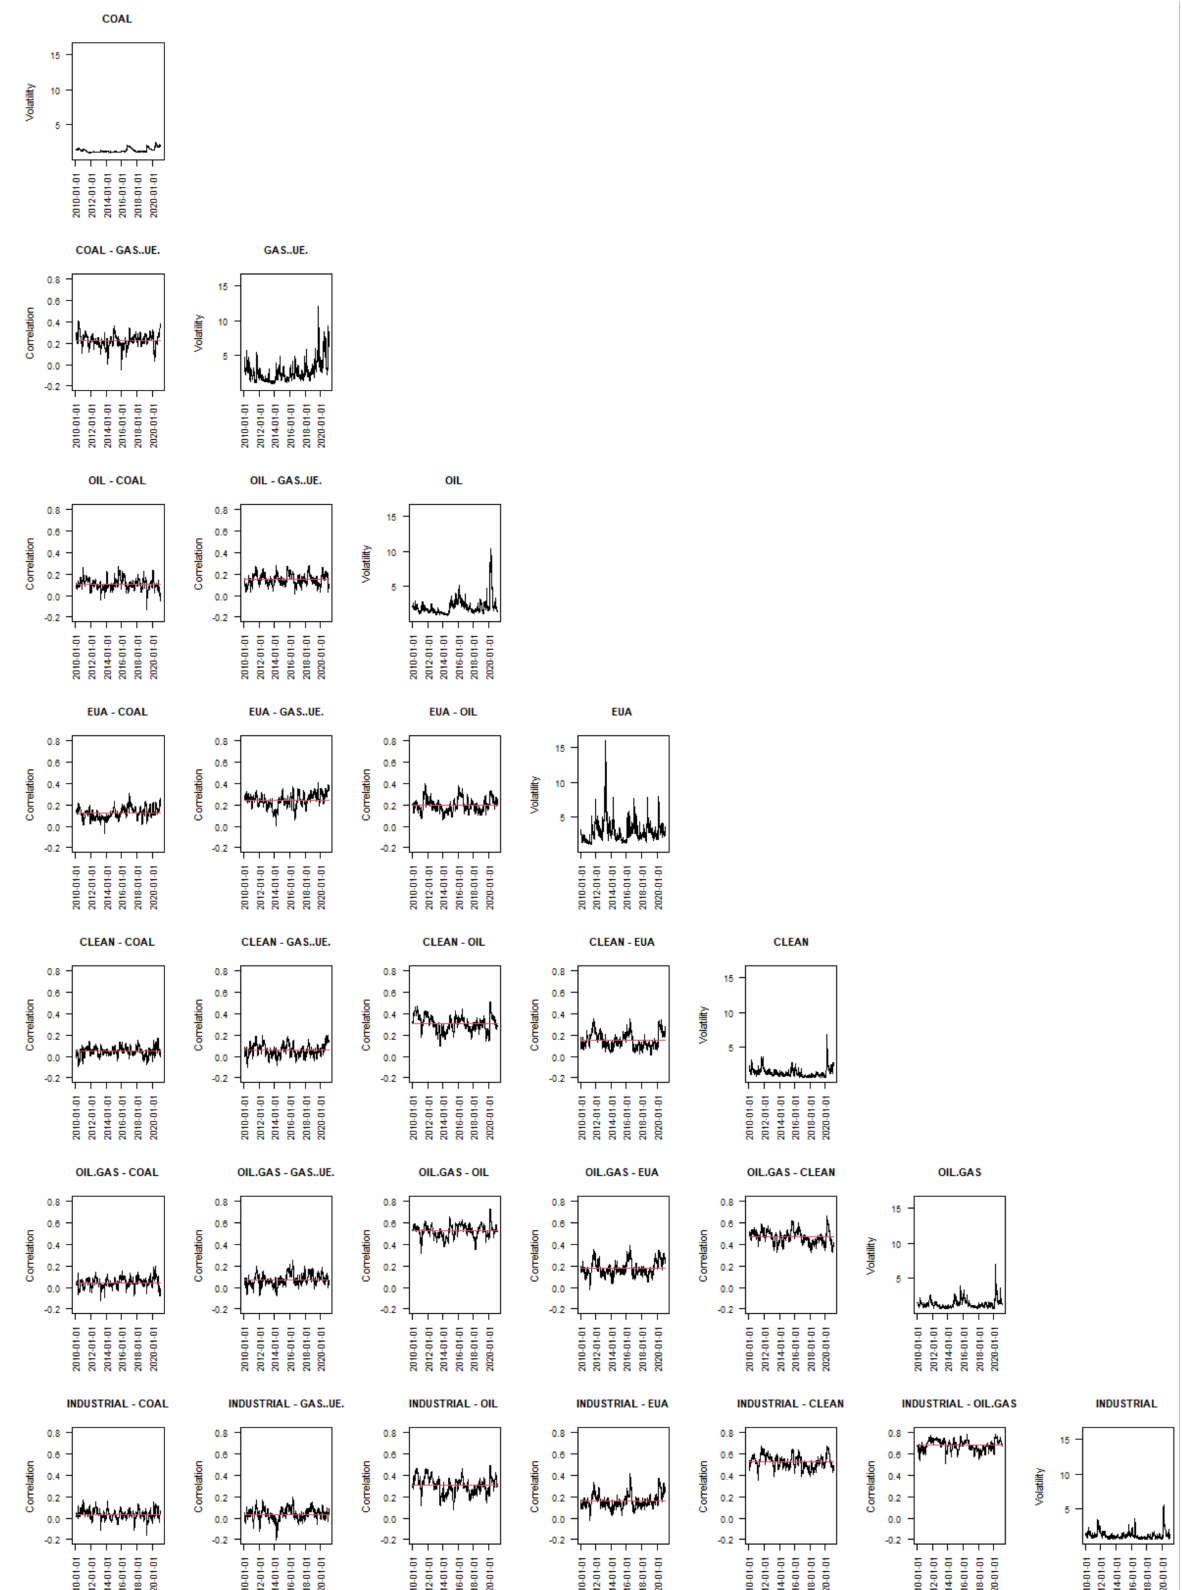
Figure 5. Matrix graph with the estimated dynamic correlation between two variables in the off-diagonal cells and with the estimated volatility of the daily returns of the seven series in the diagonal. The estimated constant correlation of a VAR(1)-CCC-GARCH(1,1) model is in